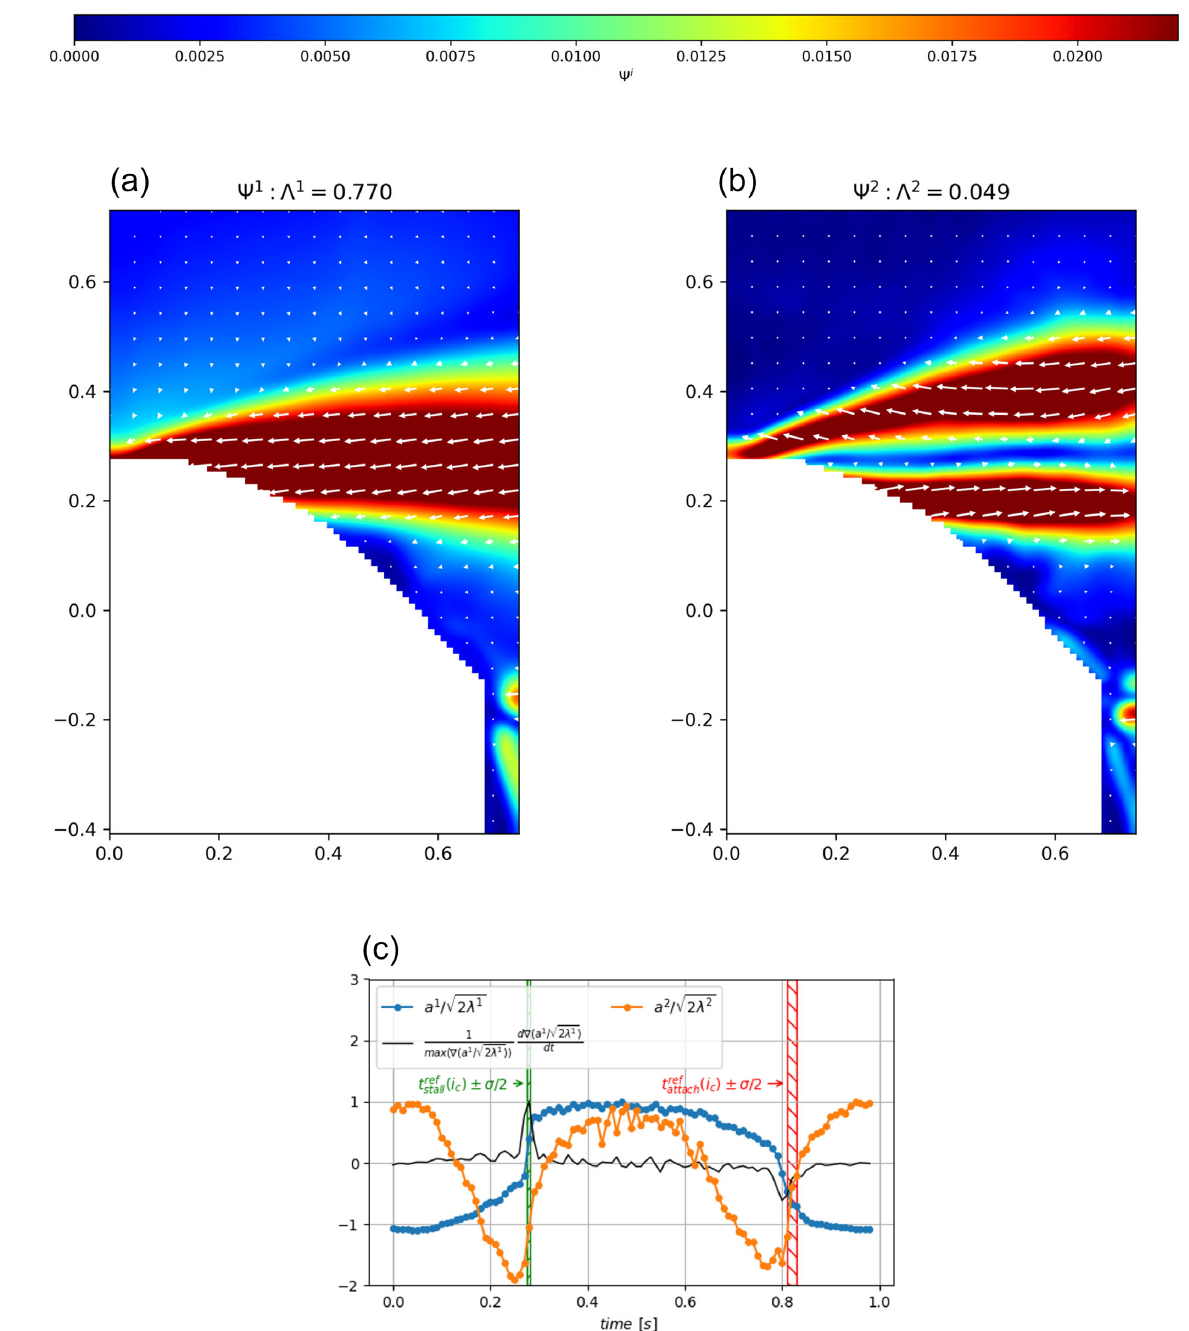
Figure 19. Third method to detect the flow stall–reattachment instants: (a) and (b) are isocontours of the eigenvector field (cid:57) n , of the n th mode, with isocontours of its modulus superimposed. (cid:51) n is the eigenvalue of the n th mode, representing the part of the turbulent kinetic energy in the mode. Panel (c) represents the phase average of the corresponding temporal coefficients scaled with their turbulent √ kinetic energy content ( a n ( t ) / 2 λ n ,n = 1 , 2) . The time window width marked by green and red hatched areas corresponds to the standard deviation σ ( t ref ( i c ) − i c .T ) centered on the average of the reference instants extracted from the instantaneous velocity fields of (stall − or − attach) Sect. 4.1, t ref ( i c ) or t ref ( i c ) stall attach